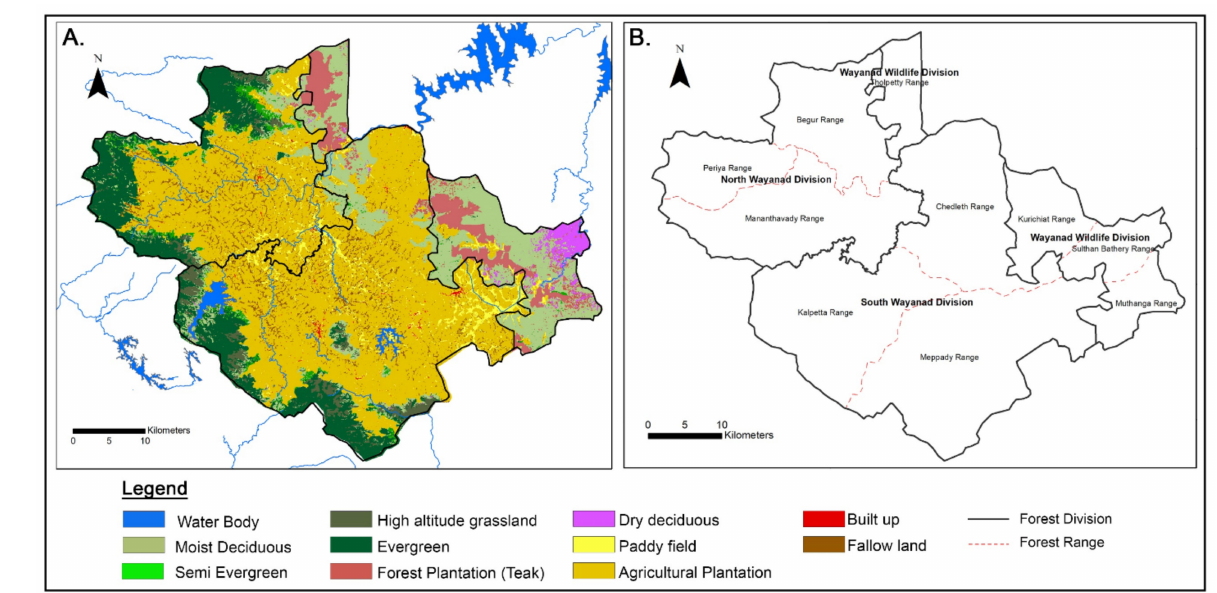
Figure 3. ( A ) Detailed LULC of Wayanad district of 2018 showing forest and agricultural plantations. ( B ) Forest divisions and ranges in Wayanad district.